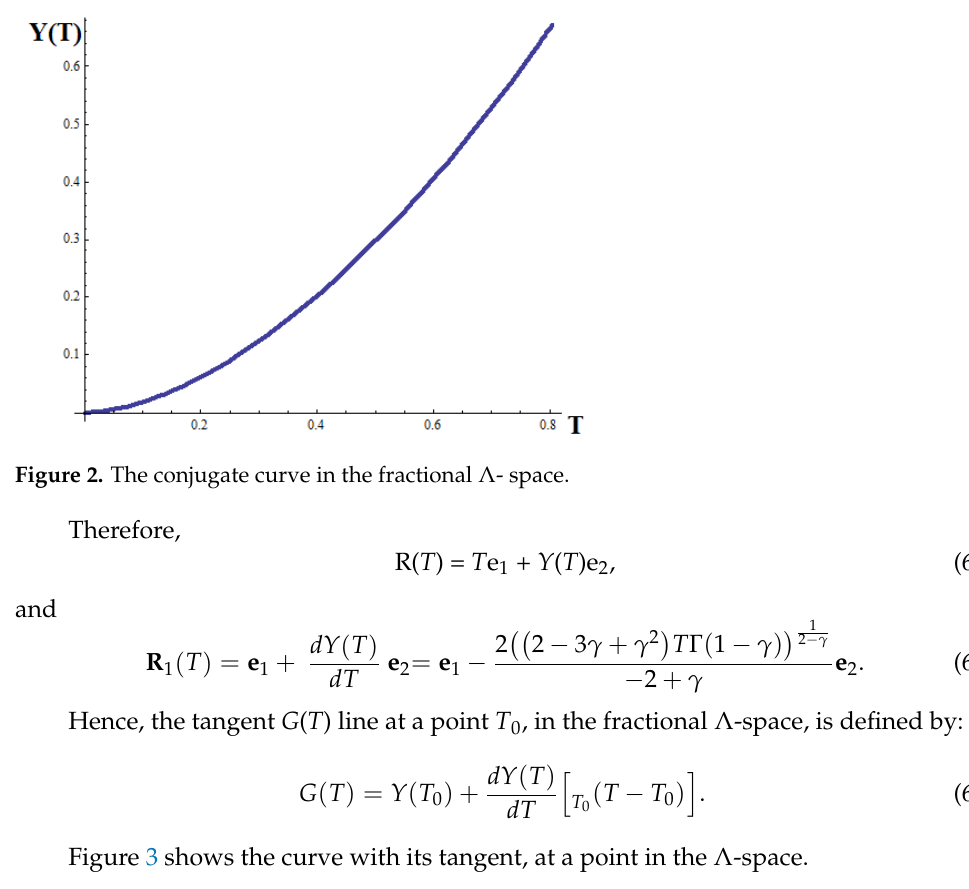
Figure 1. The curve in the original space.